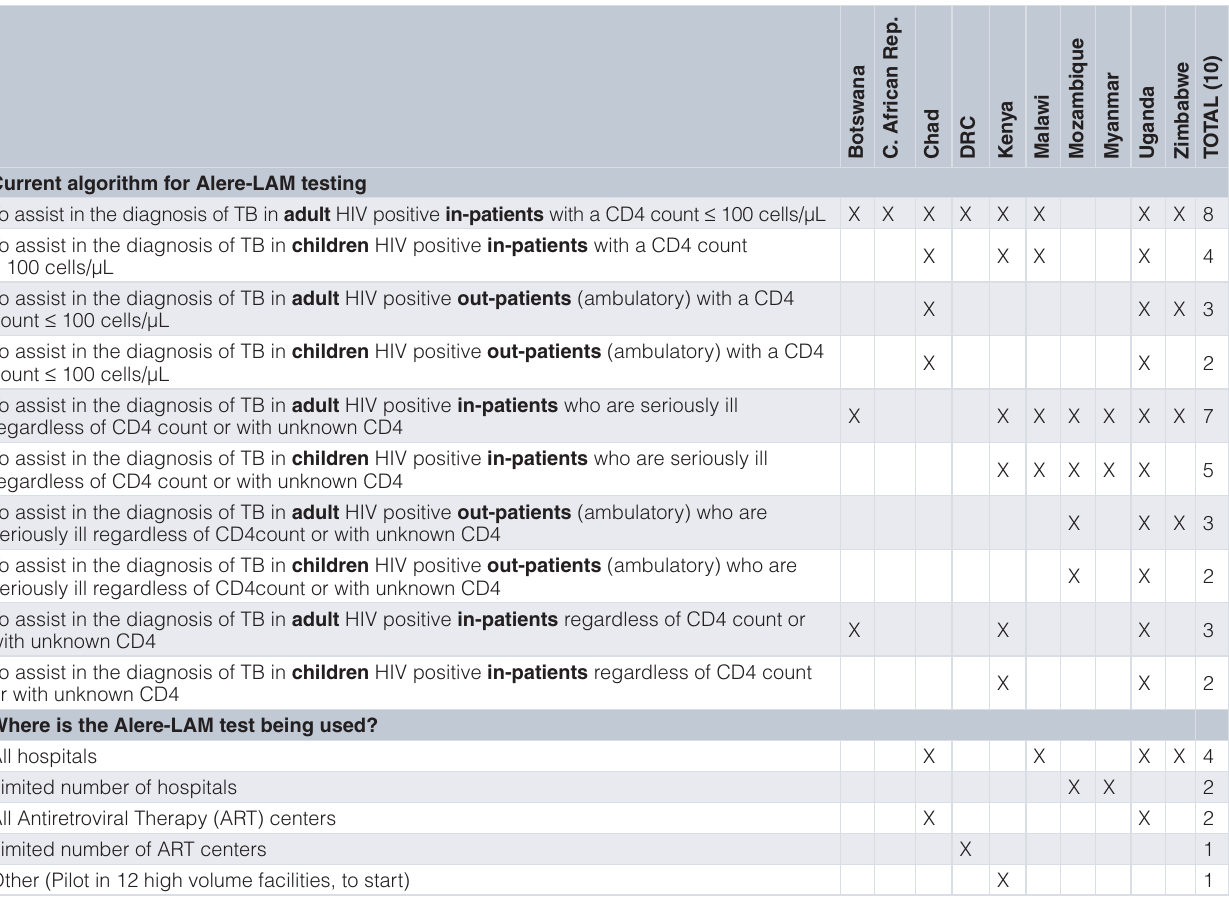
Table 2. Alere-LAM testing algorithms and its location of use.